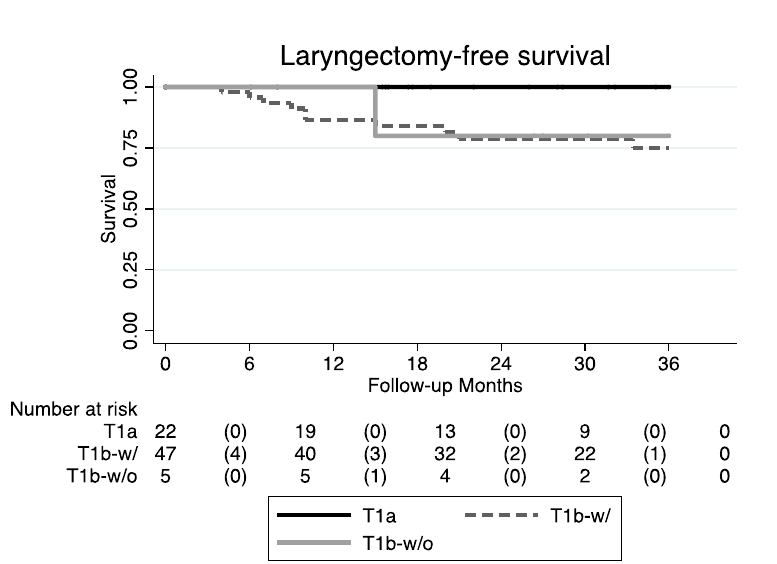
Figure 5. LFS Kaplan–Meier curves (T1b-w / : T1b with AC involvement; T1b-w / o: T1b without AC involvement).